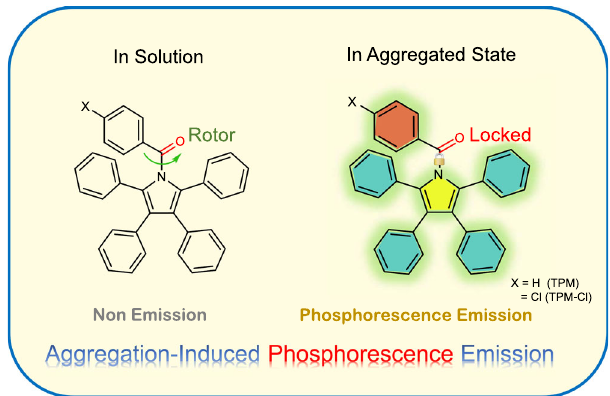
Fig. 1 Molecular design strategy. The molecular design strategy for the AIP